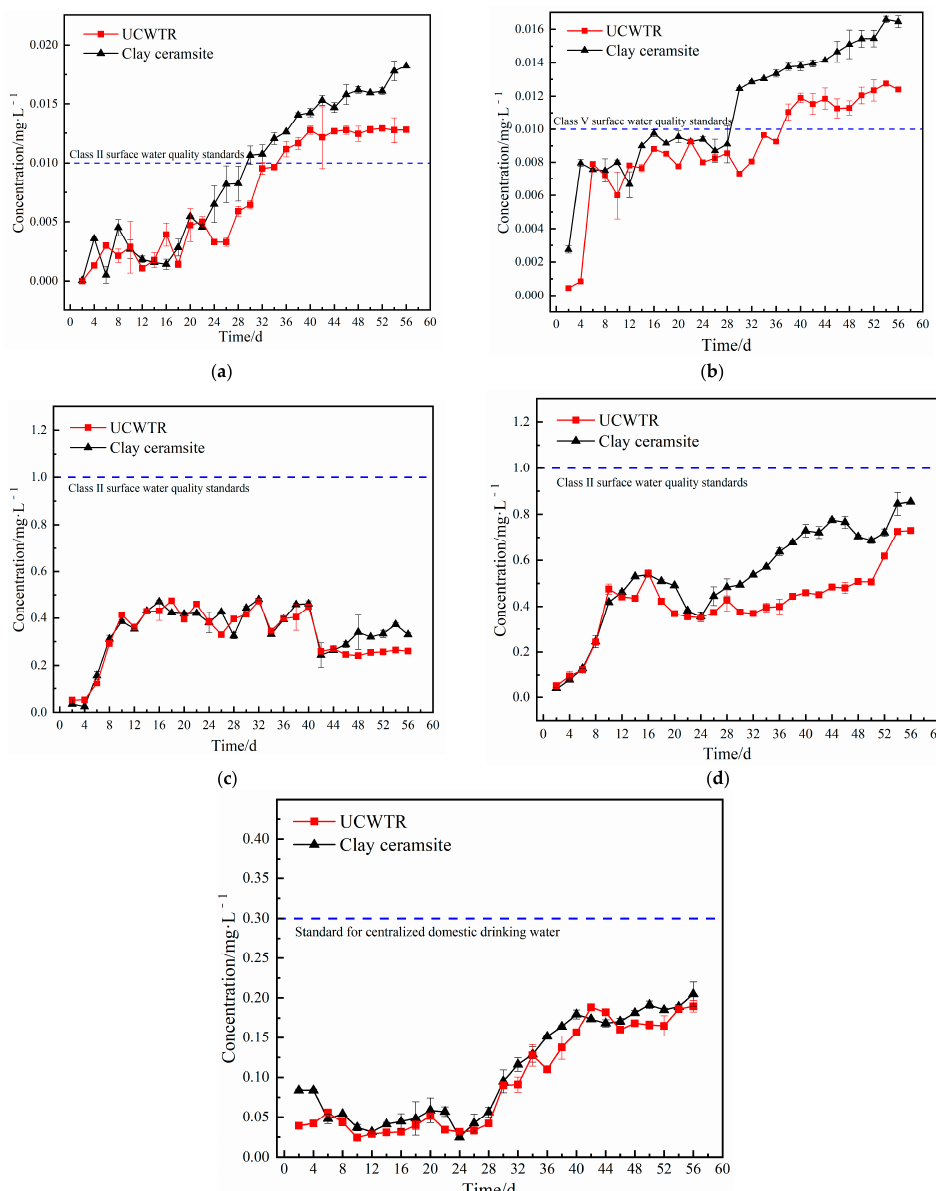
Figure 2. Changes in effluent ( a ) Pb, ( b ) Cd, ( c ) Cu, ( d ) Zn, ( e ) Fe concentration.